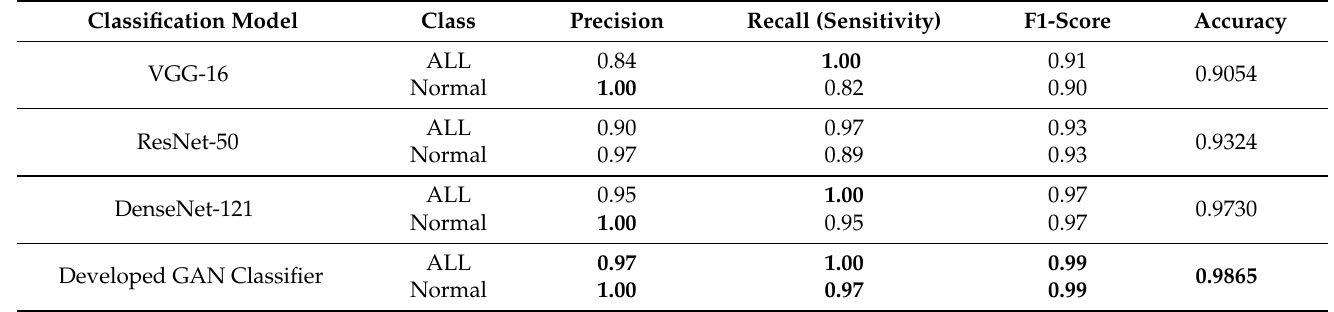
Table 2. Evaluation metrics for all tested binary classifiers on microscopic blood images.